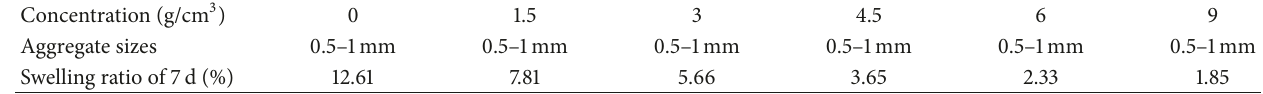
Table 4: The linear swelling ratio of specimens with different concentration of PVA.